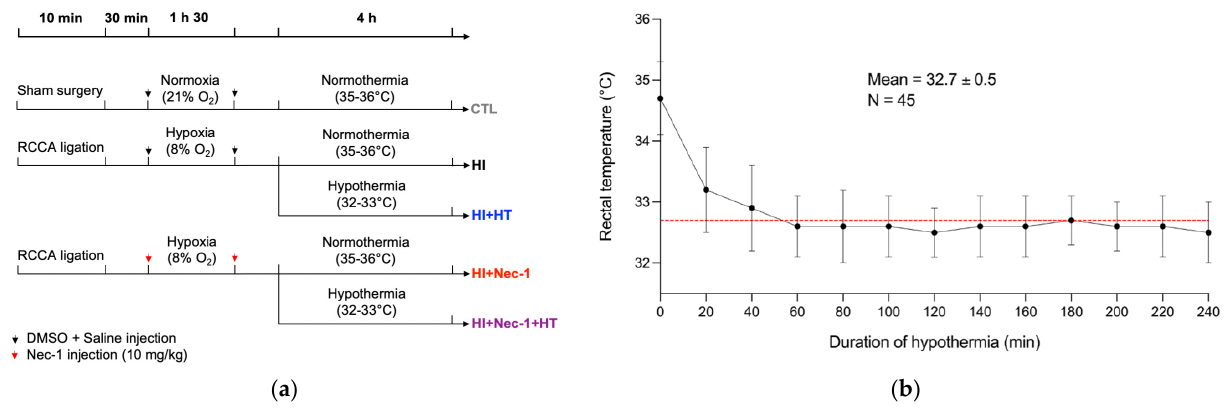
Figure 1. Experimental design. ( a ) Ligature of the right common carotid artery (RCCA) was per- formed on Lewis rat pups at P12. Necrostatin-1 or saline was injected intraperitoneally (i.p.) before and after hypoxia (8% O 2 for 1.5 h). Rat pups were treated or not by hypothermia for 4 h. For control animals, a sham surgery was followed by i.p. saline injections, without hypoxia nor hypothermia. ( b ) Rectal temperature of every pup that underwent hypothermia (n = 45 from 11 litters). The mean temperature was 32.7 °C ± 0.5 °C. Abbreviations: CTL: control; HI: hypoxia-ischemia, HT: hypother- mia.